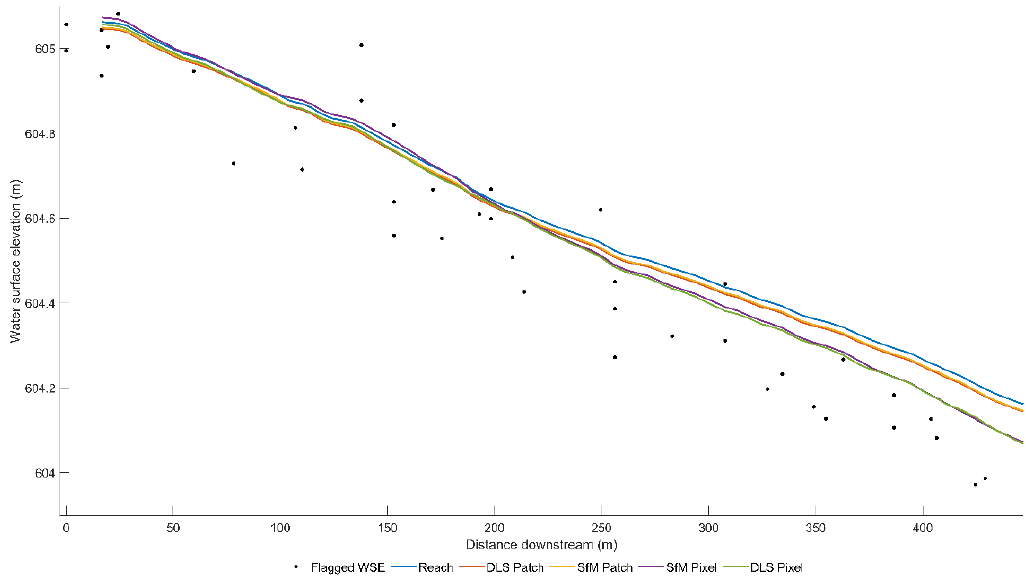
Figure 9. WSE at the flagged flood extents on 11 October 2018 compared to modeled values.